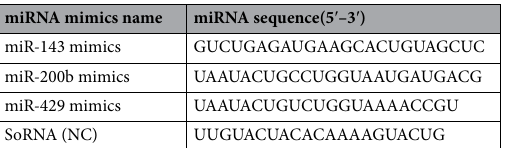
Table 3. The sequence of miRNAs which were used to chemical